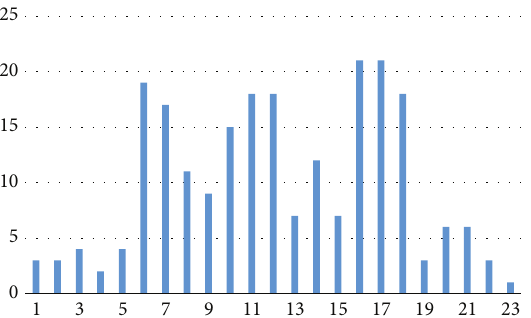
Figure 13: Spatial distribution of e-bike fatal